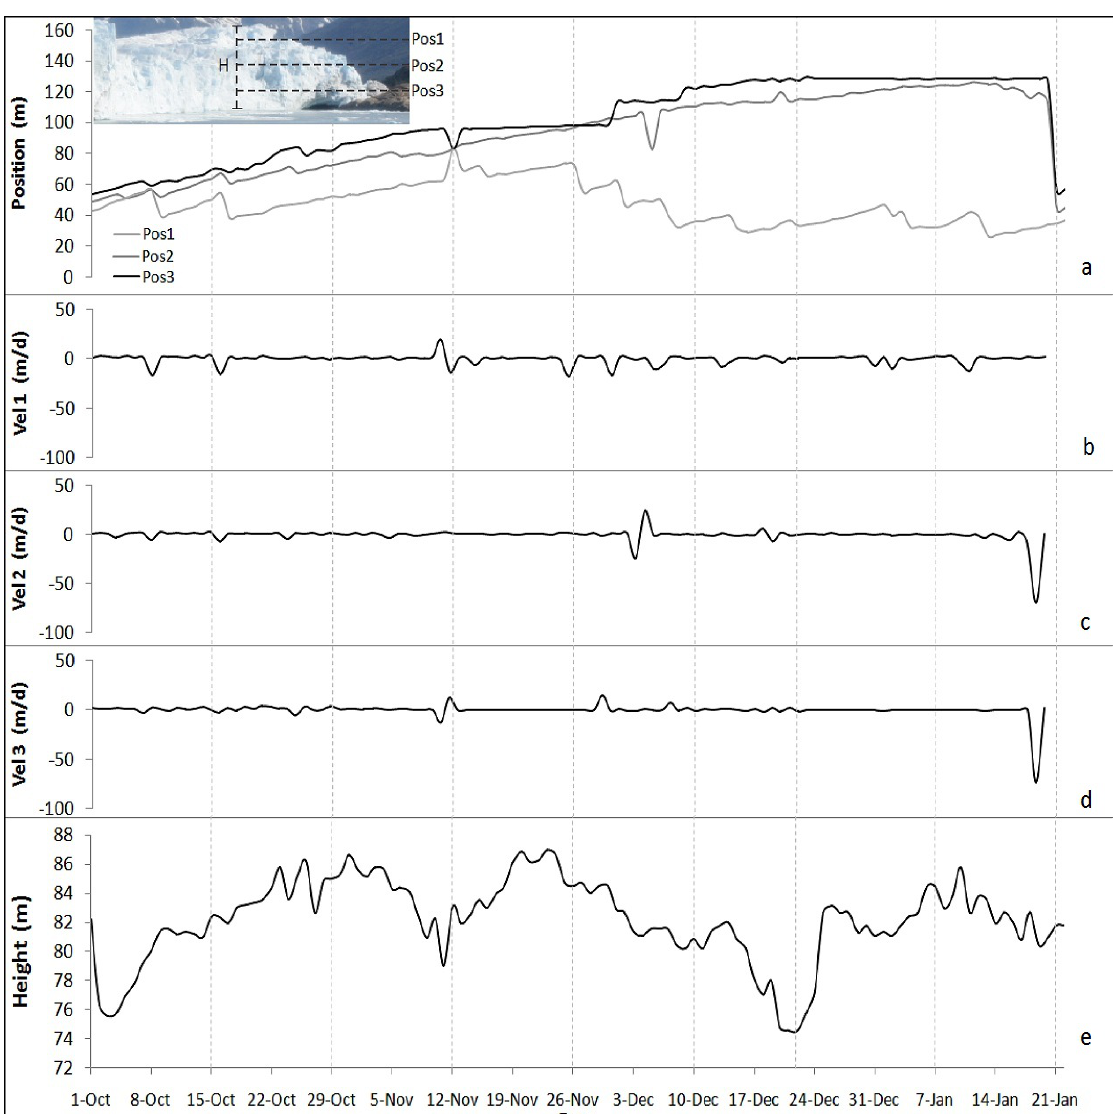
Figure 7. a: evolution of positions 1, 2 and 3; b, c and d: velocities of positions 1, 2 and 3; e: height (H) evolution of the Perito Moreno